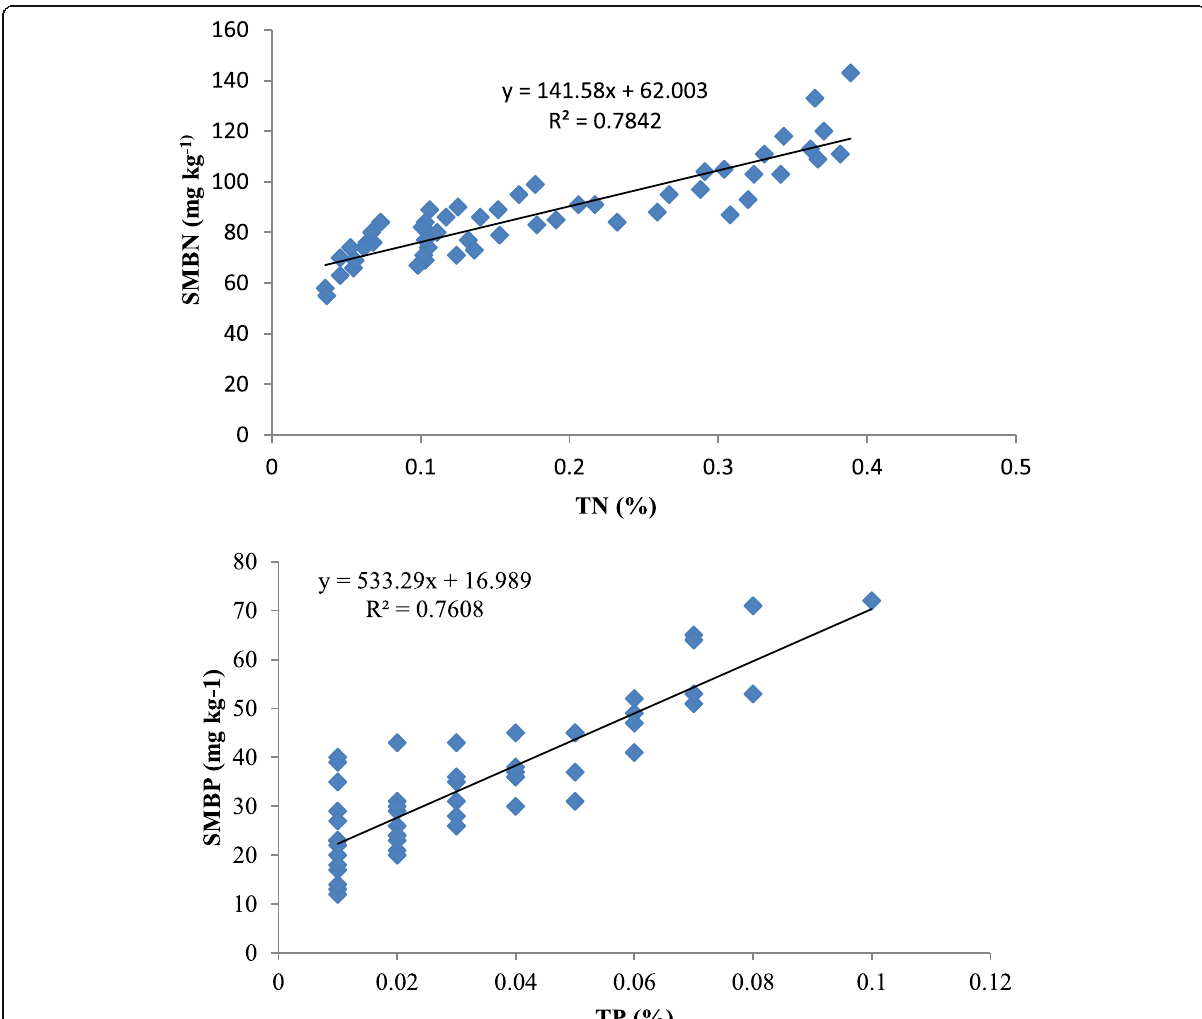
correlation between soil microbial biomass nitrogen (SMBN) and phosphorus (SMBP) and soil physical and chemical